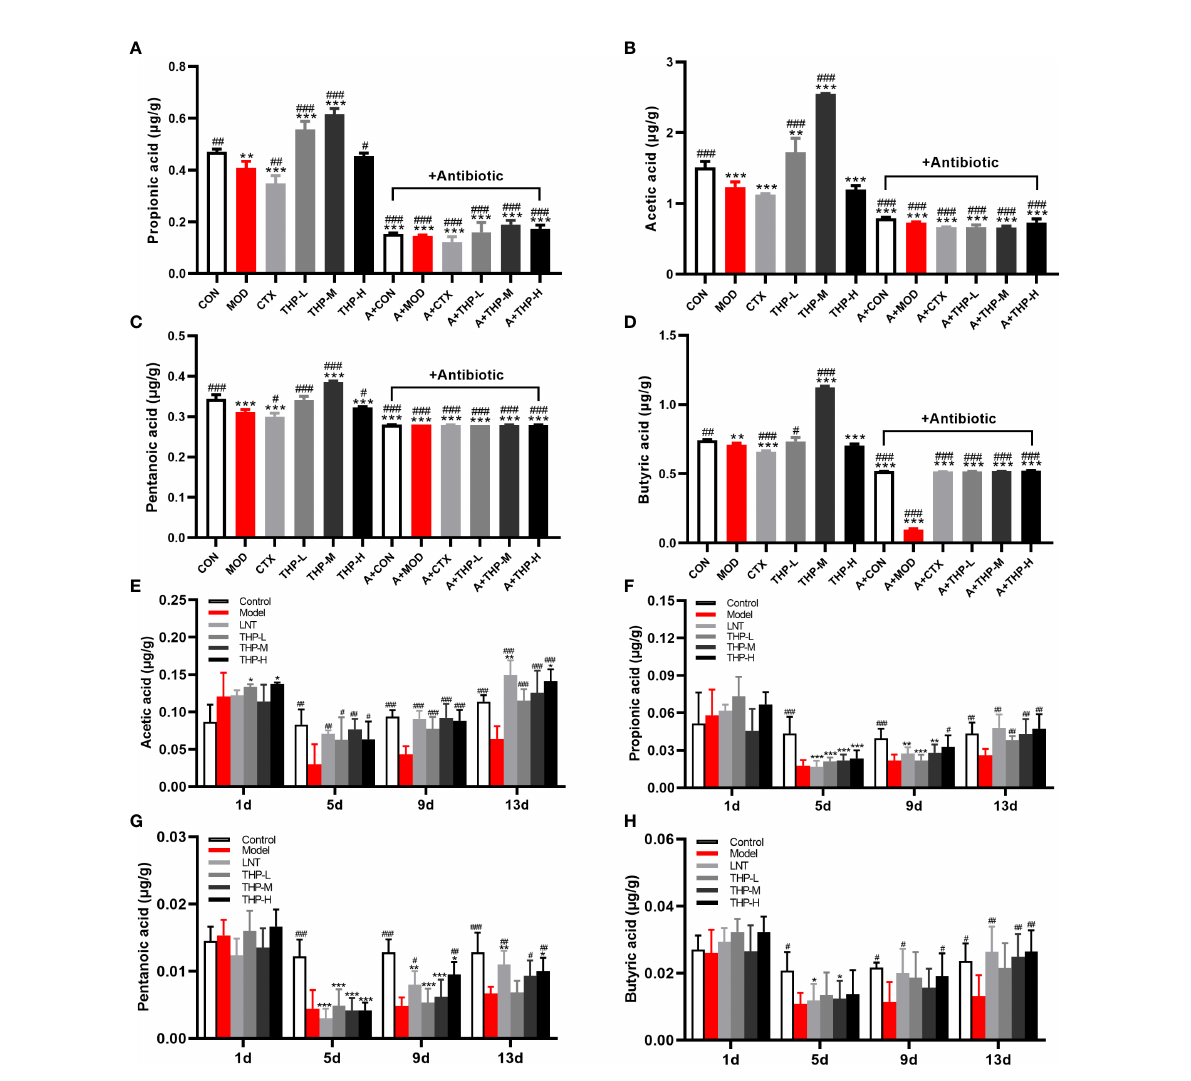
FIGURE 5 Effect of THP on the SCFAs content. (A) Propionic acid in Lewis tumor-bearing mice. (B) Acetic acid in Lewis tumor-bearing mice. (C) Pentanoic acid in Lewis tumor-bearing mice. (D) Butyric acid in Lewis tumor-bearing mice. (E) Propionic acid in immunosuppressed mice. (F) Acetic acid in immunosuppressed mice. (G) Pentanoic acid in immunosuppressed mice. (H) Butyric acid in immunosuppressed mice. Each value is presented as the mean ± SD. *P < 0.05, **P < 0.01, ***P < 0.001 versus CON or Control; # P < 0.05, ## P < 0.01, ### P < 0.001 versus MOD or